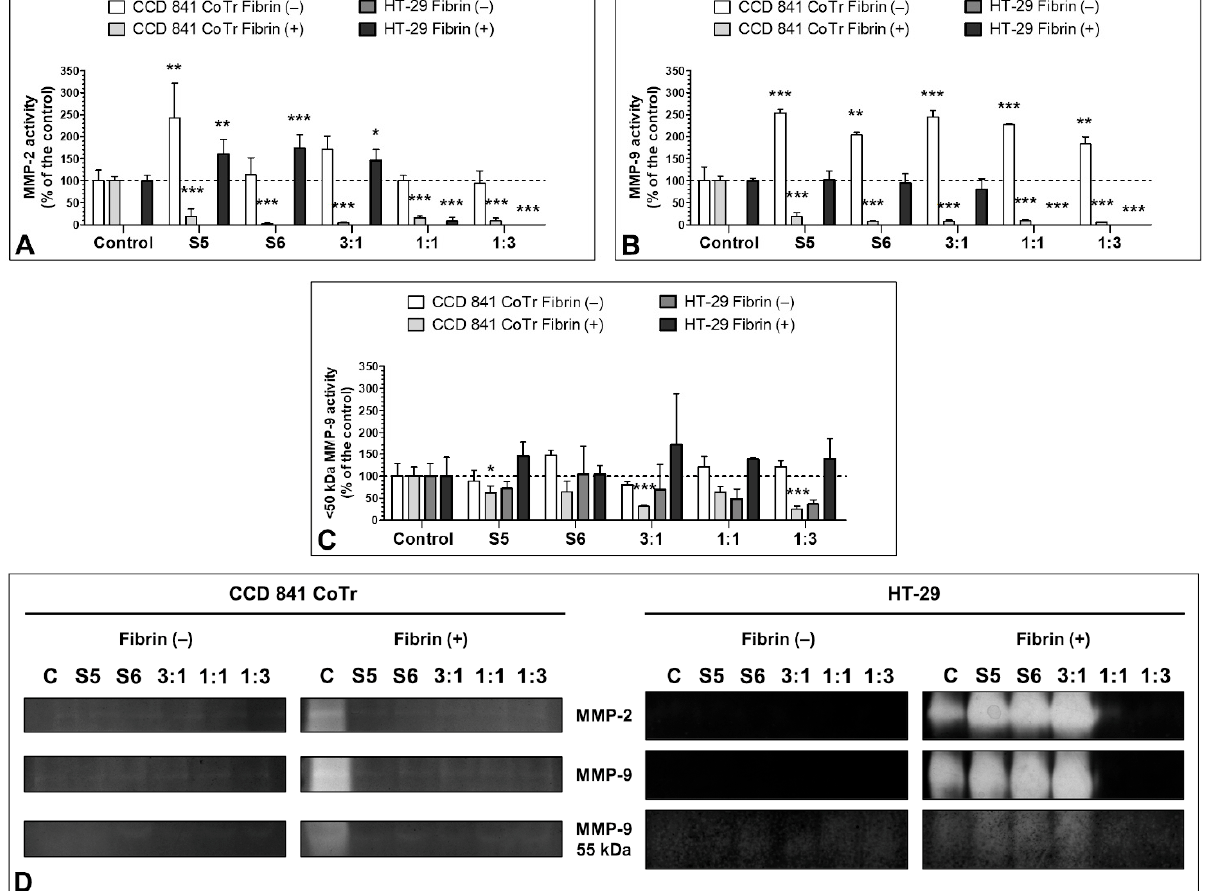
Figure 7. Gelatin zymography of CCD 841 CoTr and HT-29 MMPs in the presence of the S5 and S6 fractions and fibrin matrix. Effect of the S5 and S6 fractions at 300 µg/mL administered individually and in combinations (3:1, 1:1, 1:3) on the activity of MMP-2 ( A ) and MMP-9 ( B ) secreted by the CCD 841 CoTr and HT-29 cells induced with 2.5 mg/mL fibrinogen measured with gelatin zymography method. The results of the activity of MMPs secreted by cells with no fibrin matrix were below the limit of detection (as seen in zymograms on panel ( D )). Effect of S5 and S6 on the <50 kDa isoform of MMP-9 secreted by the CCD 841 CoTr and HT-29 cells ( C ). The presence of fibrinogen clots induced the activity of MMPs. Furthermore, the activity of MMP-2 was increased by S5, S6, and 3:1 variants, with no effect on the activity of MMP-9. The activity of the <50 kDa isoform of MMP-9 was decreased by all variants, with the strongest effect exerted by the 1:1 and 1:3 fraction ratios. * p < 0.05; ** p < 0.01; *** p < 0.005; one-way ANOVA, n = 4, post hoc: Dunnett’s test.